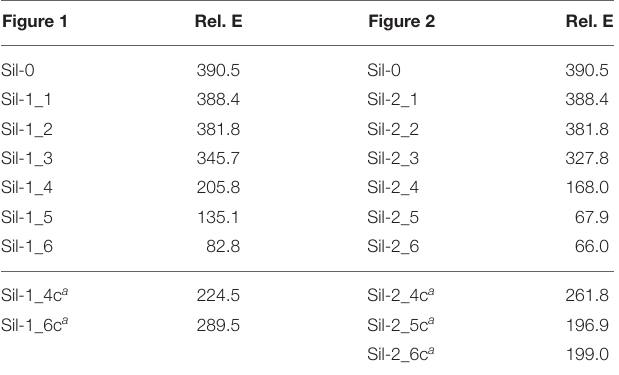
TABLE 2 | Relative energies (in kcal mol − 1 ) of the periodic silicate structures shown in Figures 1 , 2 with respect to the bulk forsterite Mg 2 SiO 4 crystal (per unit formula).